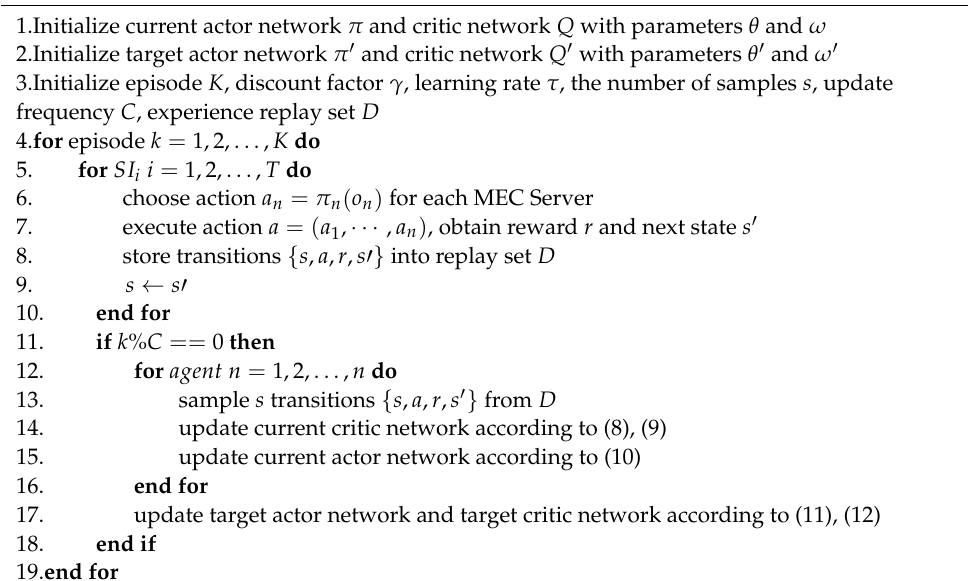
Algorithm 1 VM migration strategy based on